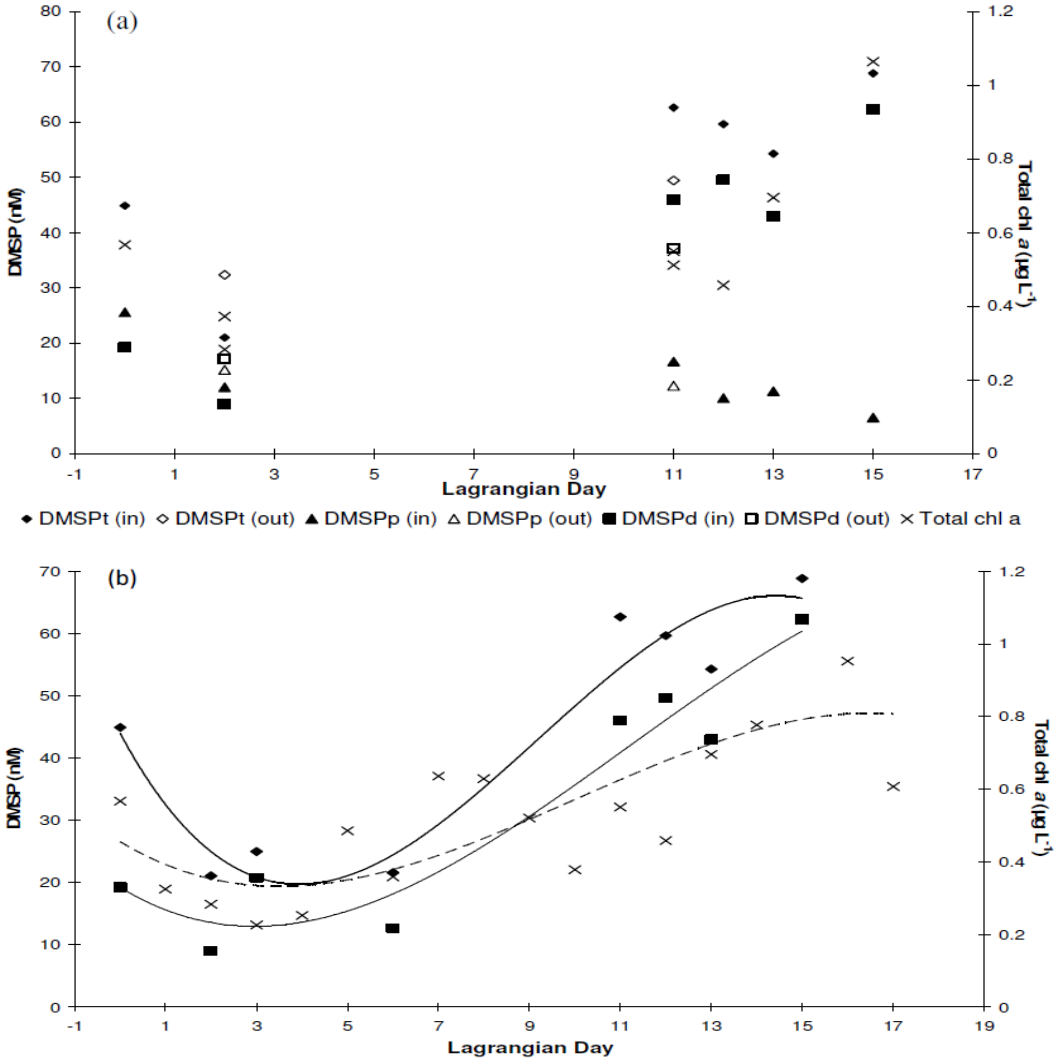
Figure 6. ( a ) Depth-integrated dimethylsulfoniopropionate (DMSP) fractions and chlorophyll a in the upper 90 m ( (cid:7) = DMSPt (IN), (cid:78) = DMSPp (IN), ∆ = DMSPp (OUT), (cid:4) = DMSPd (in), (cid:3) = DMSPd (out), × = chl a (IN)) and ( b ) modelled lines (polynomial fit) for depth-integrated DMSPt ( (cid:7) ), DMSPd ( (cid:4) ), and chl a ( × ) versus Lagrangian day.